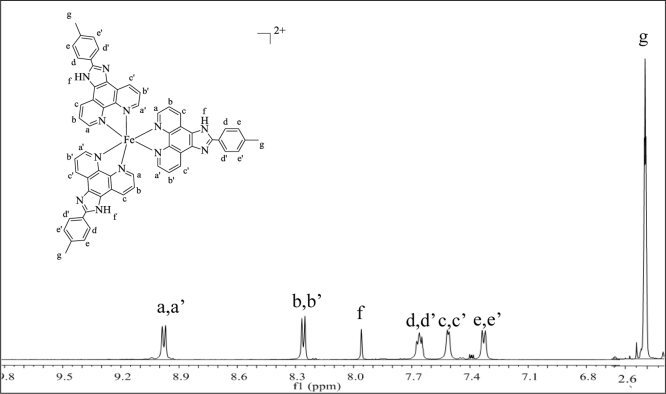
1H NMR spectrum (500 MHz) of complex 5 in dimethylsulfoxide-d6.